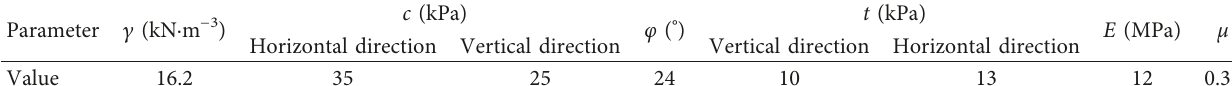
Table 3: The mechanical parameters of